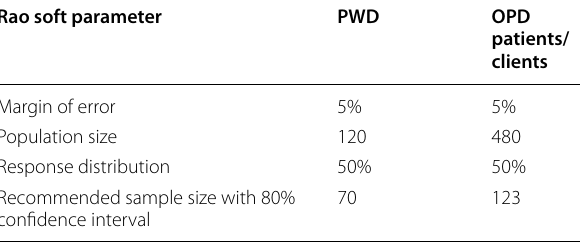
Table 1 Calculation of the sample size of the study Rao soft